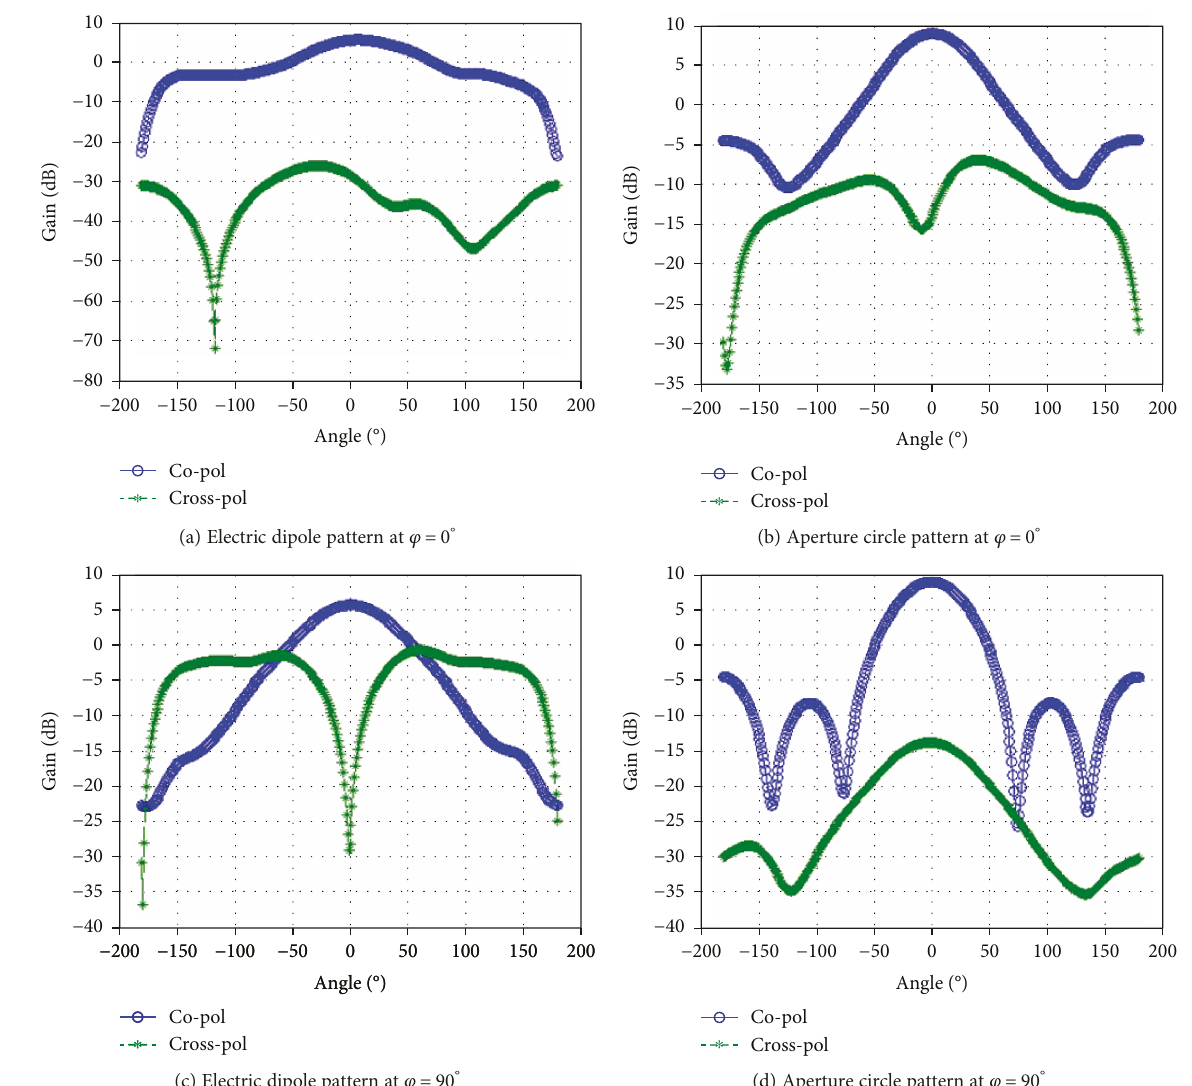
Figure 6: Simulation pattern of dual polarized